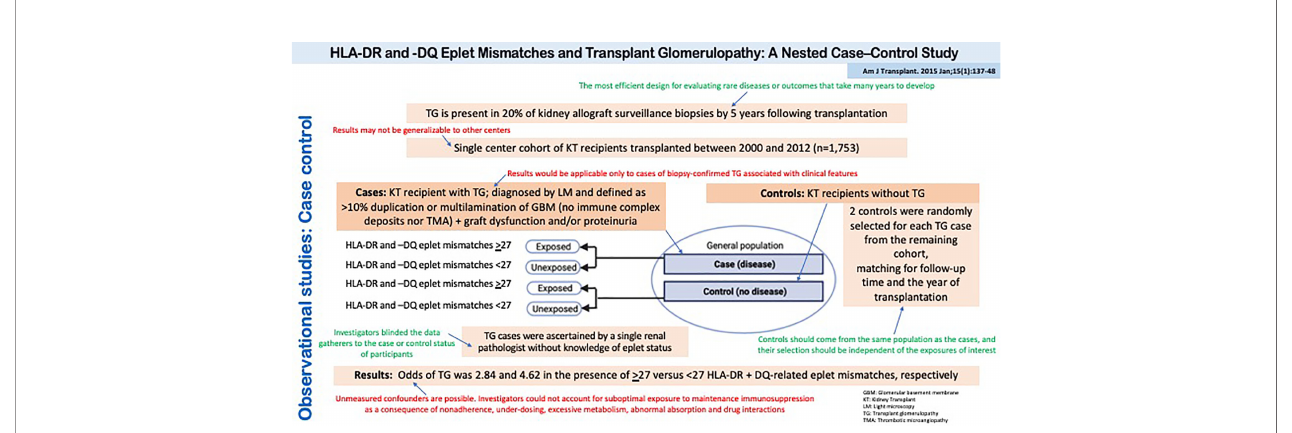
FIGURE 6 | Observational studies: Case Control. HLA-DR and -DQ Eplet Mismatches and Transplant Glomerulopathy: A Nested Case – Control